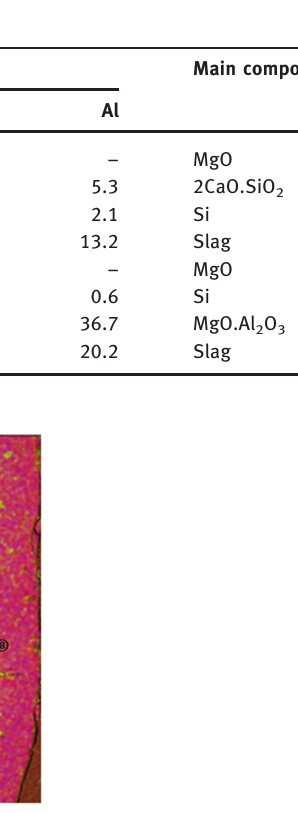
Figure 6: EDS analysis of MgO-C cathode interface produced in different slag for a: CaO-SiO 2 -Al 2 O 3 slag and b: CaO-SiO 2 -Al 2 O 3 -10% MgO slag